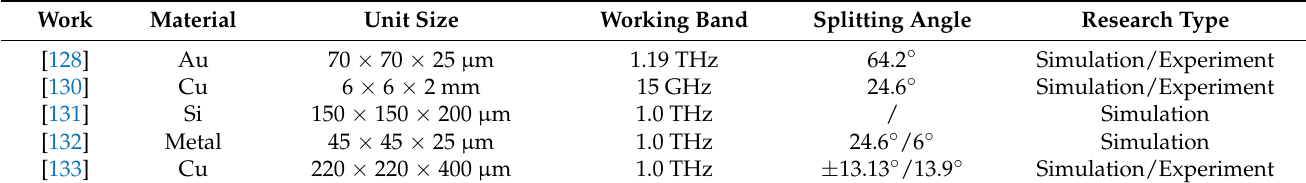
Figure 15. ( a ) The unit cell of a single-layer, hole-shaped copper metasurface [133]. ( b ) Simulation diagram of the coding metasurface beam splitter; the sequence is “000111...” [133]. ( c ) Simulation image of the checkerboard metasurface with “0101…/1010…” encoding [133]. Table 7. Parameters of coding metasurface beam splitters described in this